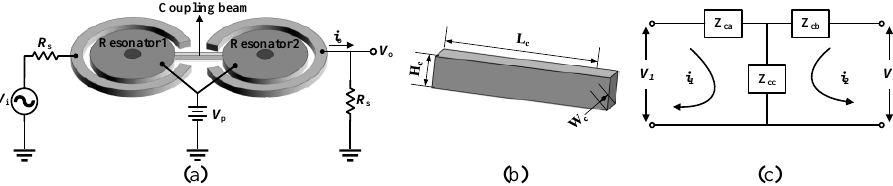
Figure 5. ( a ) Figure of mechanically coupled resonators; ( b ) Dimension of the coupling beam; and ( c ) T-shaped capacitor model for the coupling